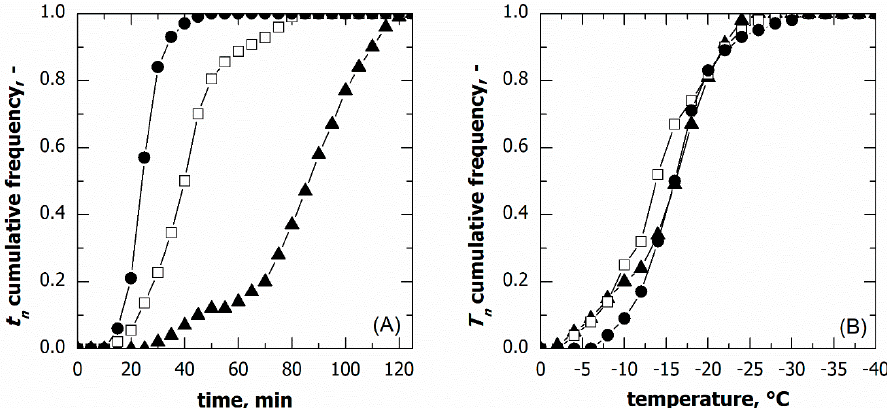
Figure 5. Cumulative distribution for ( A ) the ice nucleation time and ( B ) the ice nucleation temperature in the case of vials nested in a rack system. Data refer to various cooling rates: ( ▲ ) 0.25, ( □ ) 0.50, and ( ● ) 1.00 °C min − 1 .